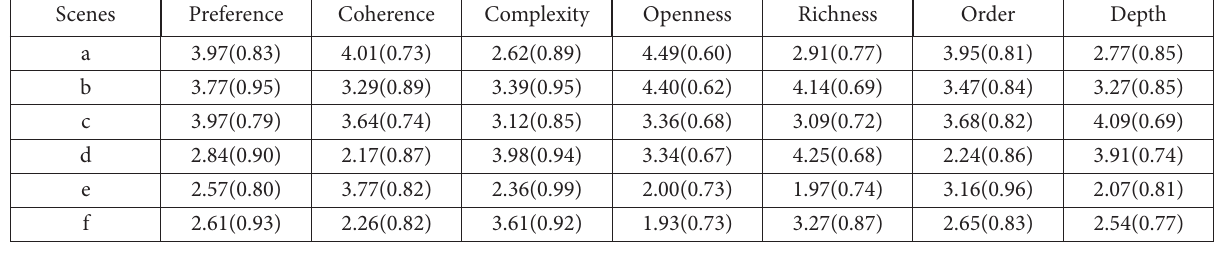
Table 2. Means of rating for preference and the variables for the scenes Scenes